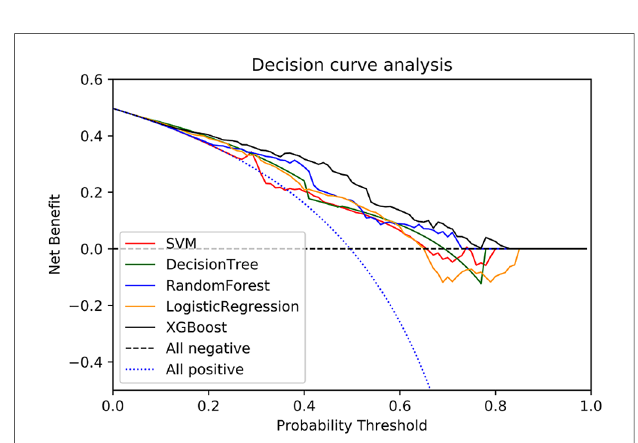
FIGURE 3 A decision curve was used to evaluate the clinical utility of models. The y axis shows net income. the x axis shows the threshold probability. Within a reasonable threshold probability range, the XGBoost model in the validation set achieved higher bene fi ts.